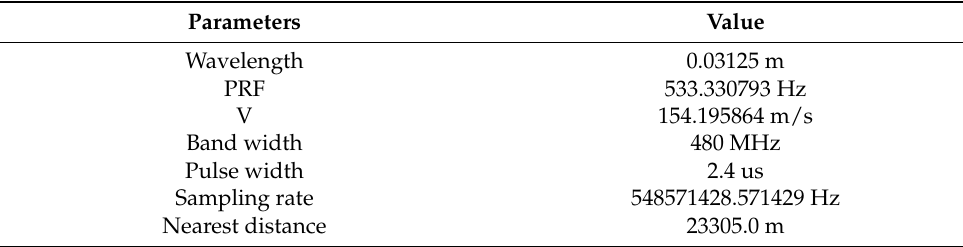
Table 2. Simulation and experimental